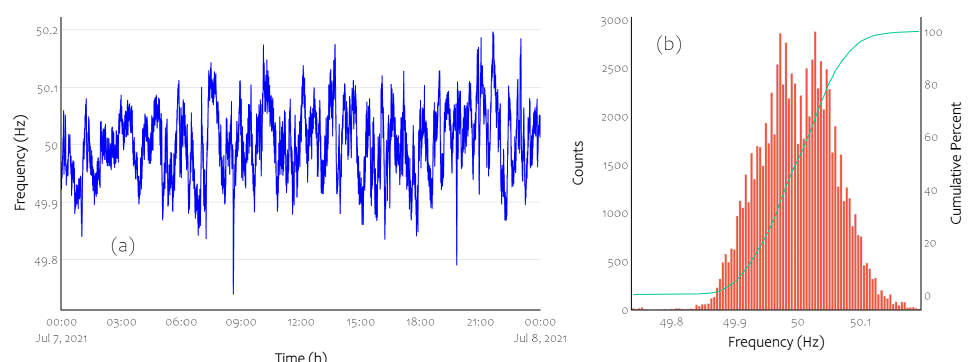
Figure 3. ( a ) Time series data of 24-h GB working day system frequency signal used for testing. ( b ) Histogram of frequency